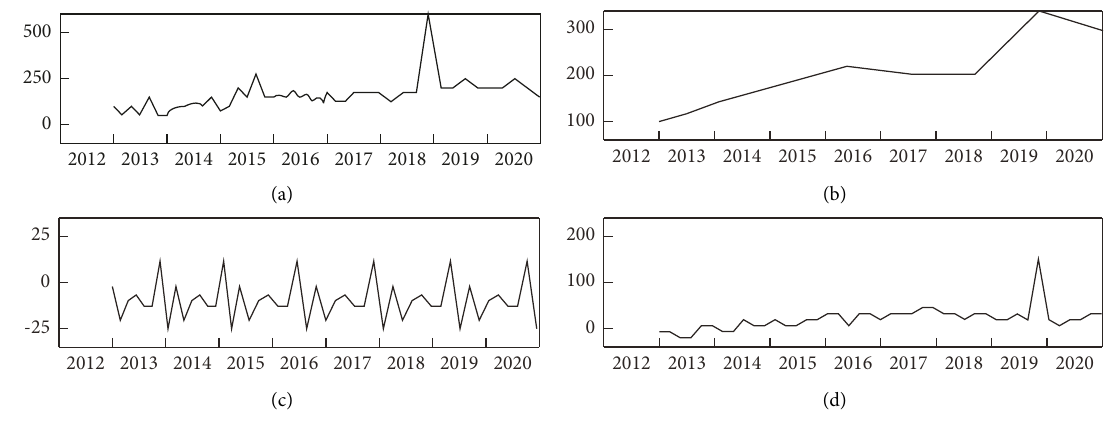
Figure 1: Time-series breakdown of a port cargo